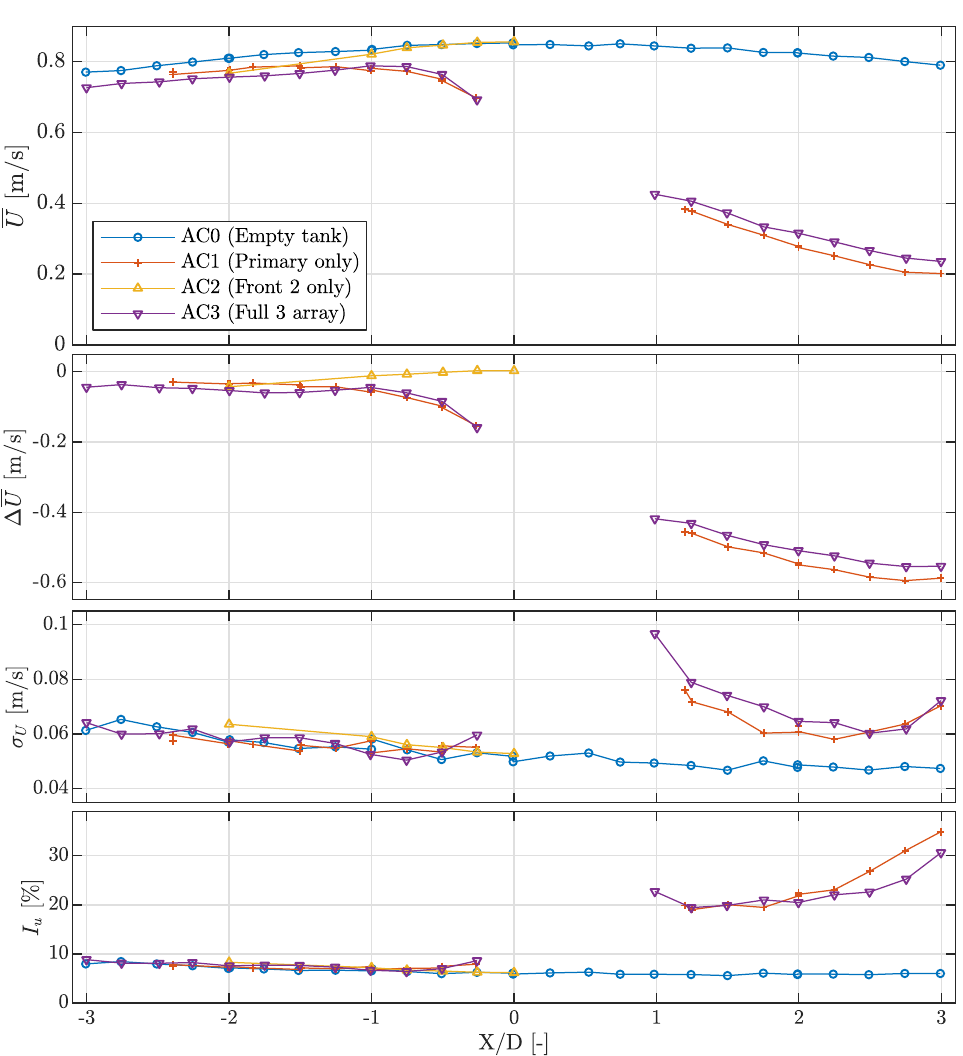
Figure 4. Transect along centreline of array ( Y / D = 0) at hub height. Sub-panels show mean velocity U , mean velocity relative to empty tank ∆ U , standard-deviation σ U , and turbulence intensity I U